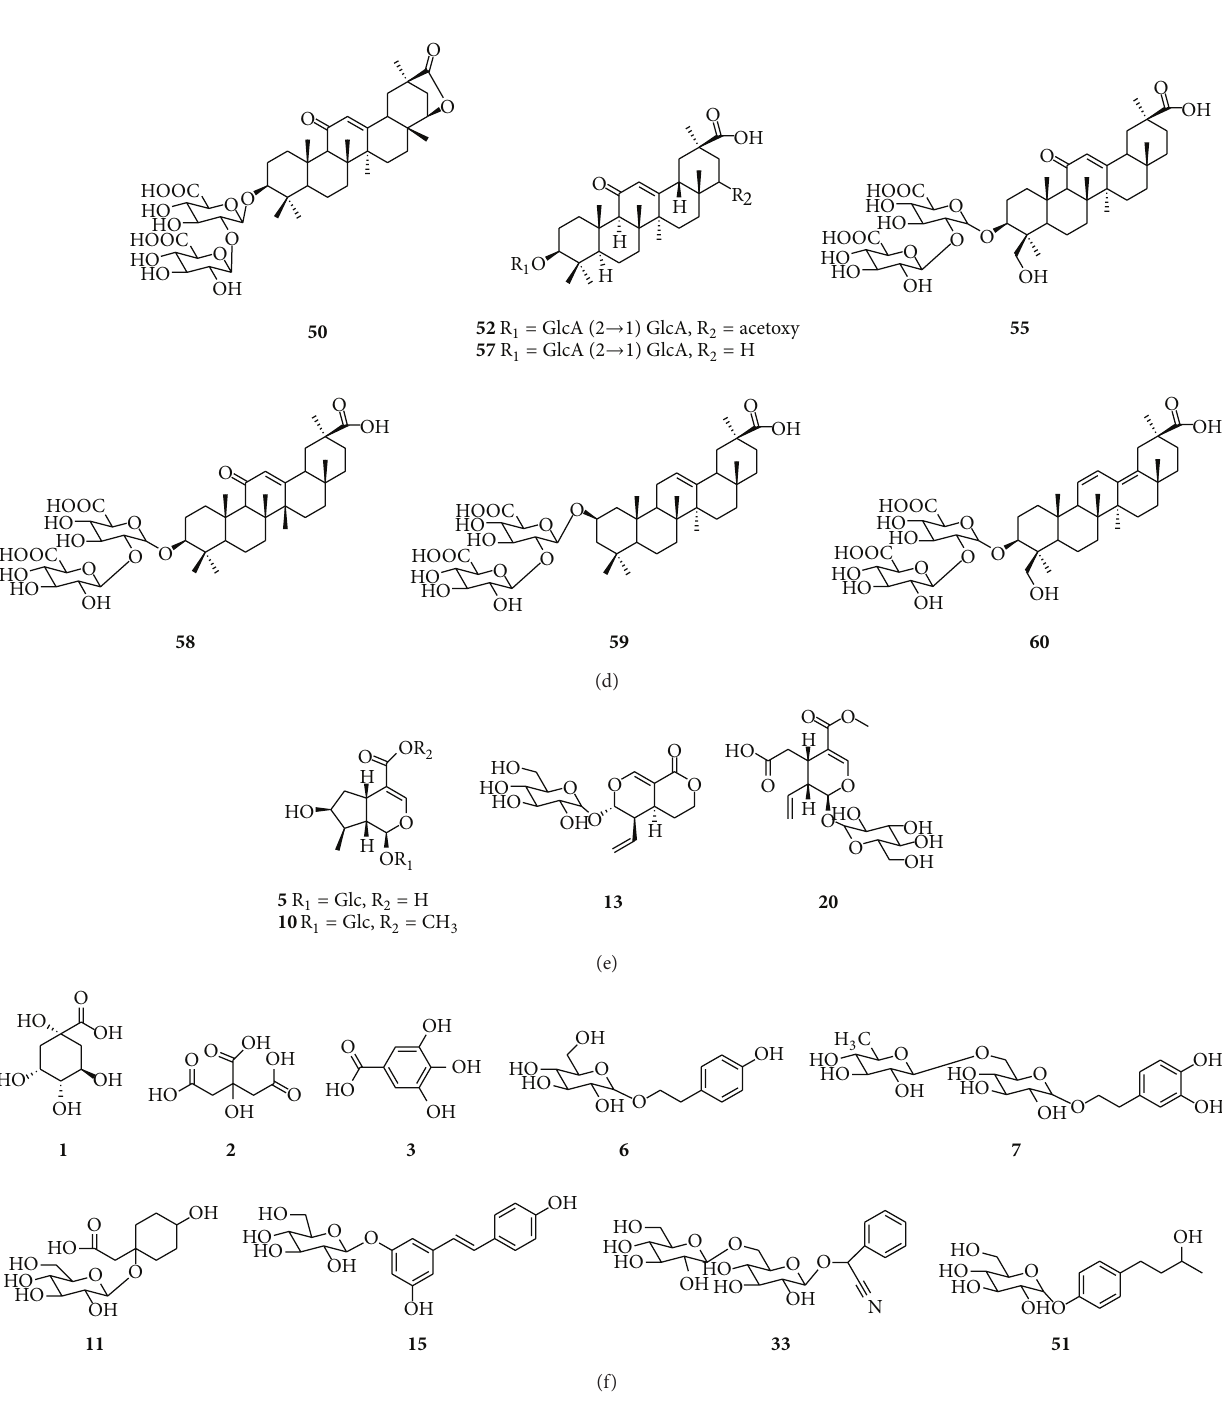
by comparing the molecular mass and MS/MS data with literature data [25,